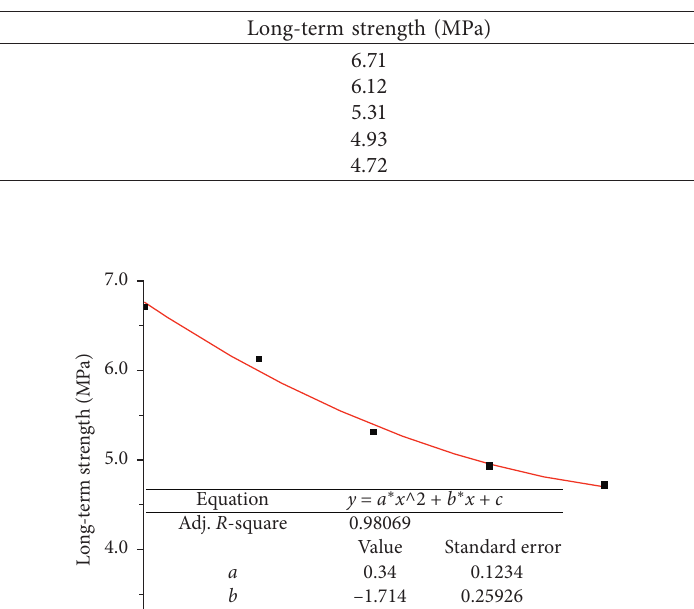
Table 3: Long-term strengths under different water pressures.